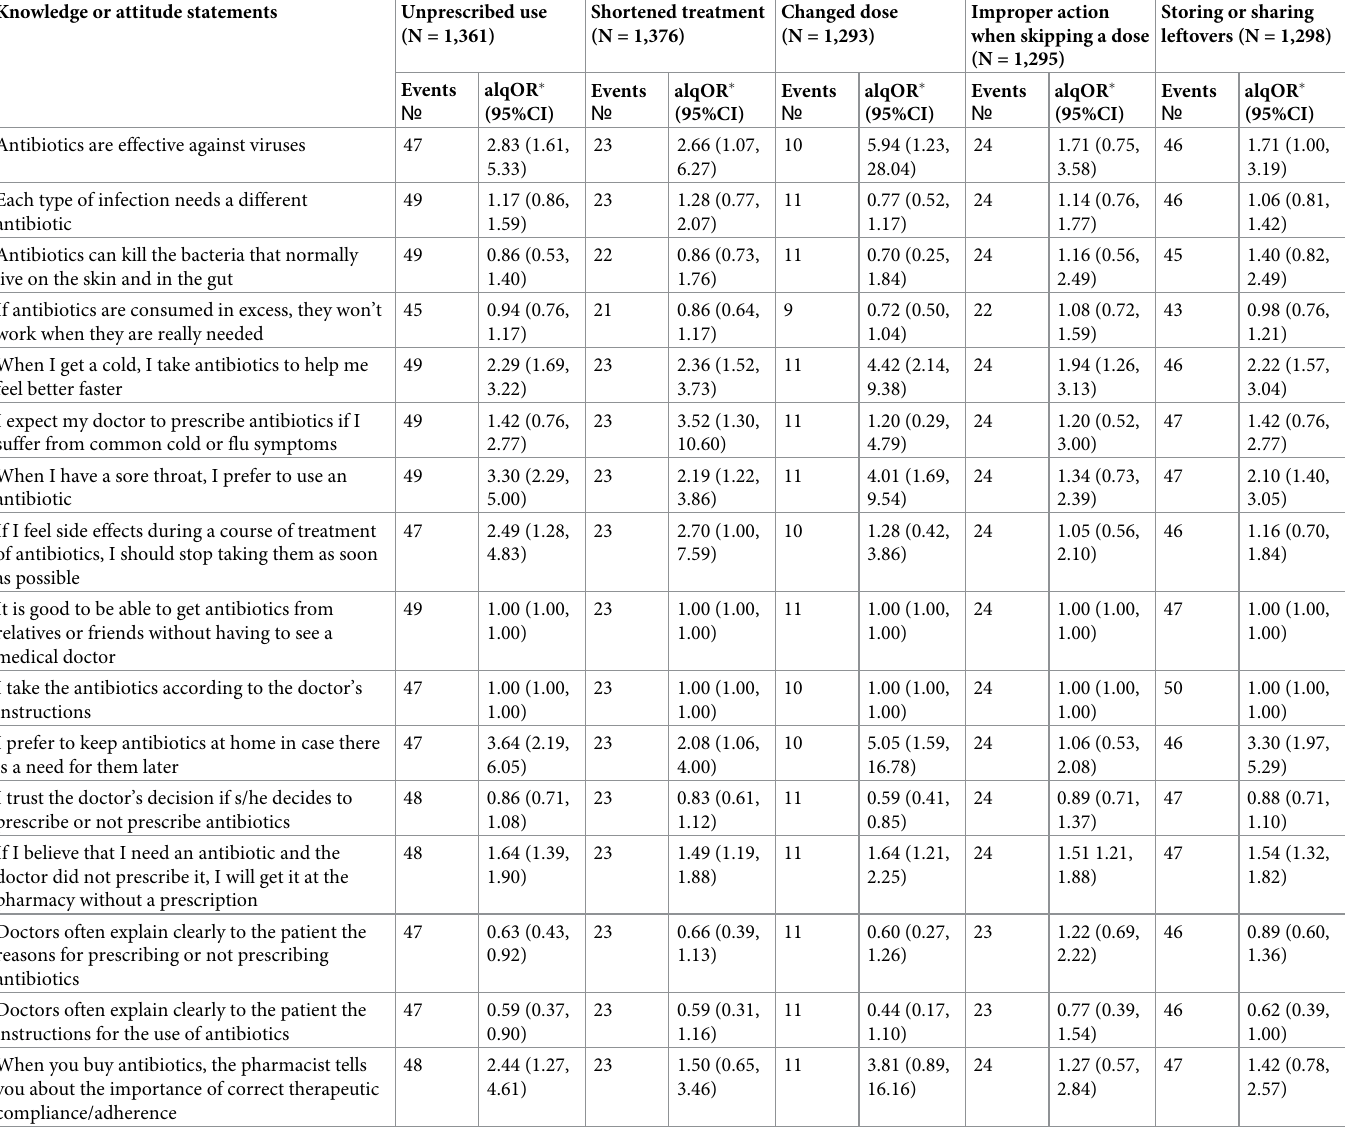
Table 3. Association of knowledge and attitudes with the different aspects of antibiotic´s misuse in parents of